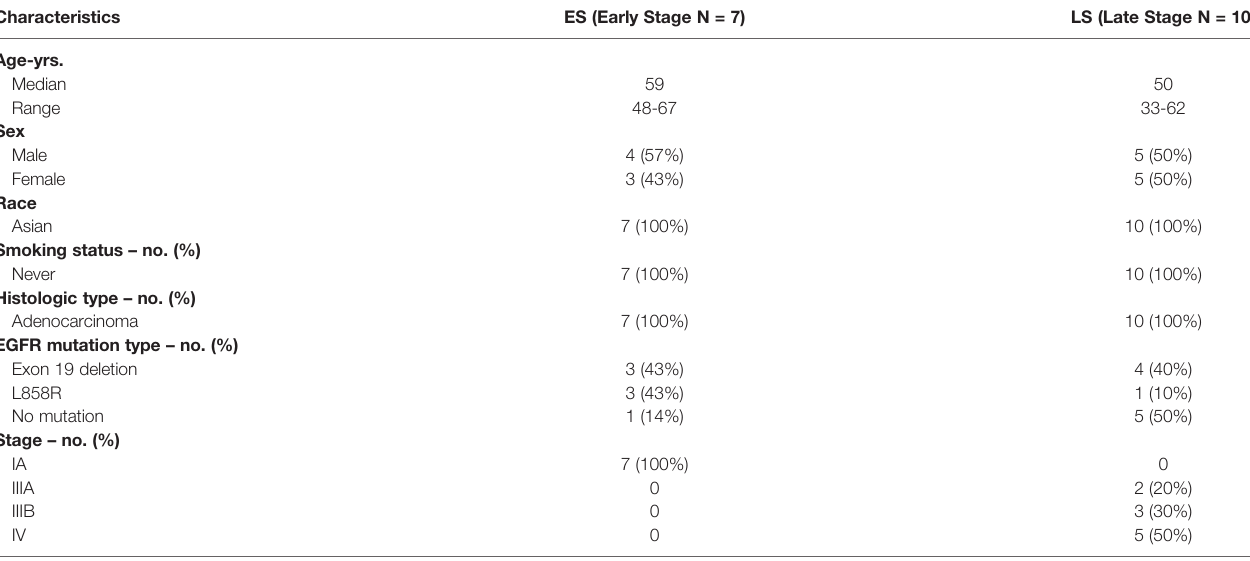
EGFR, epidermal growth factor receptor; ES, Early Stage; LS, Late